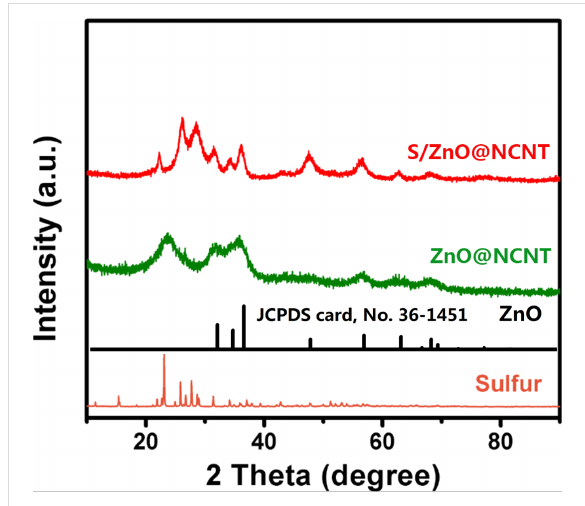
Figure 1: XRD patterns of S, ZnO@NCNT and S/ZnO@NCNT com-